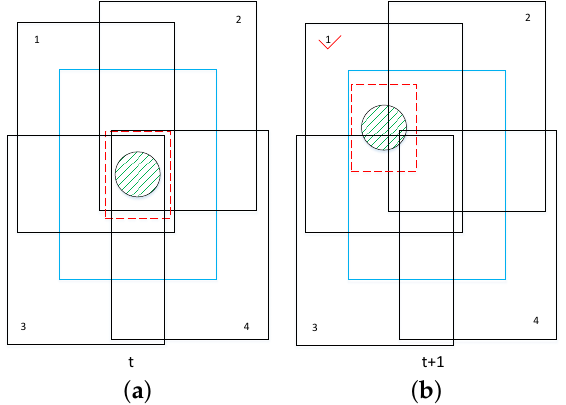
Figure 4. Tracking process diagram. It shows that, during tracking process, we train a regression by finding samples near the object in frame t and use the regression to estimate the displacement of the tracked object in frame t + 1: ( a ) the object’s state in frame t ; and ( b ) the object’s state in frame t + 1. The tick symbol means that No. 1 box receives responses the